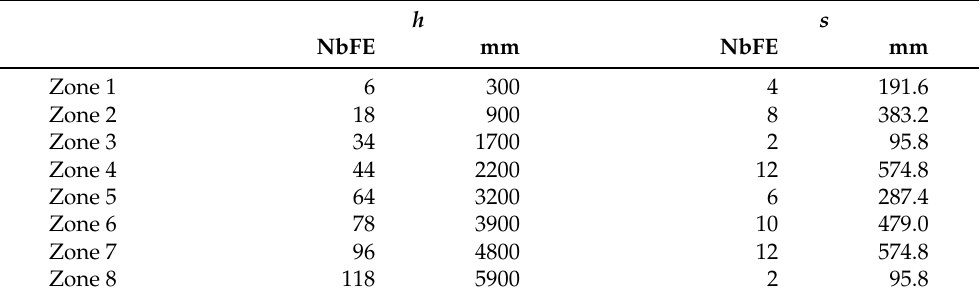
Table 2. The parameters h and s expressed in number of elements and in length